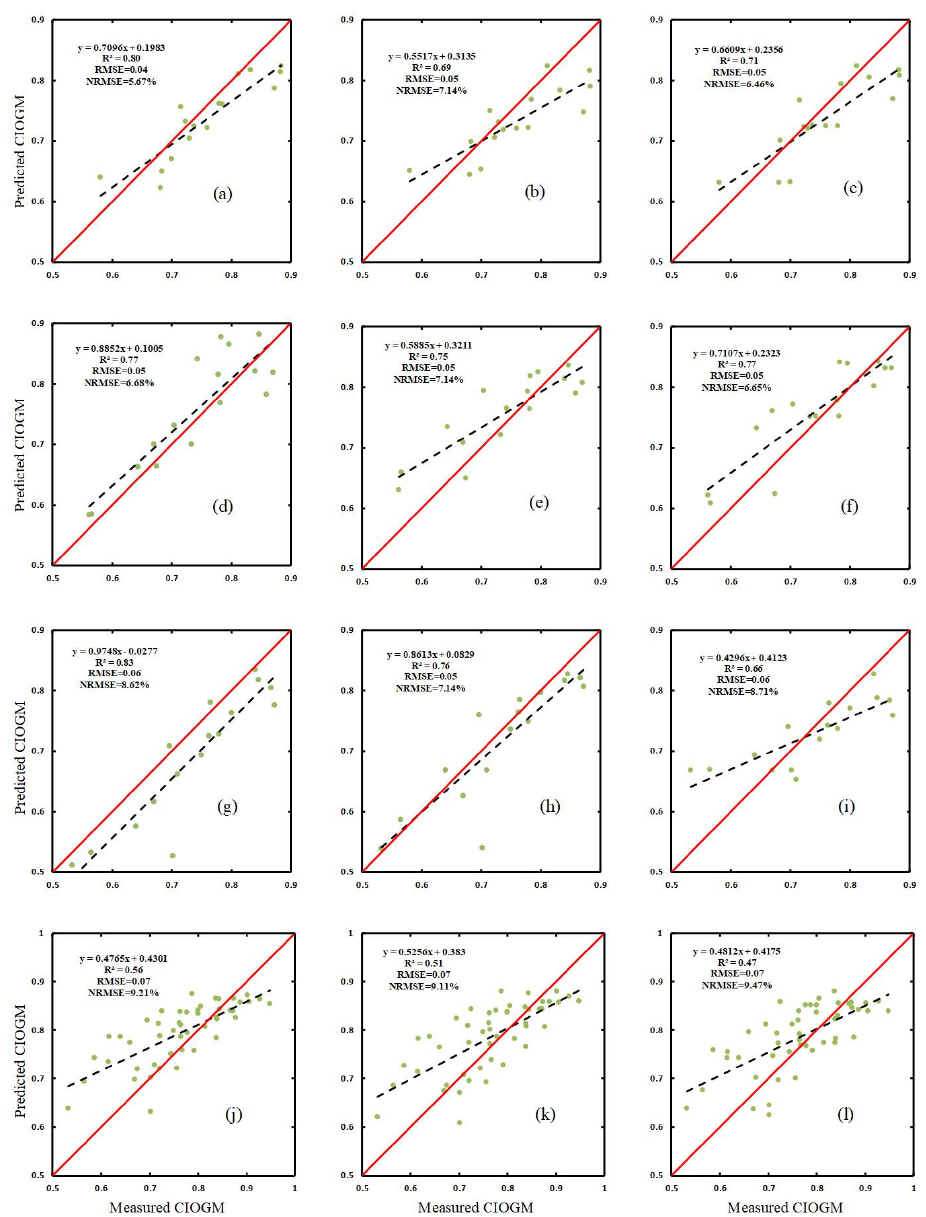
Figure 3. Relationship between the CGI predicted vs. the CGI measured by RGB VIs using ( a – c ) MLR, PLSR, and RF models at (GS 31), respectively; ( d – f ) MLR PLSR, and RF models at (GS 47), respectively; ( g – i ) MLR, PLSR, and RF models at (GS 65), respectively; and ( j – l ) MLR, PLSR, and RF models over the three stages, respectively.